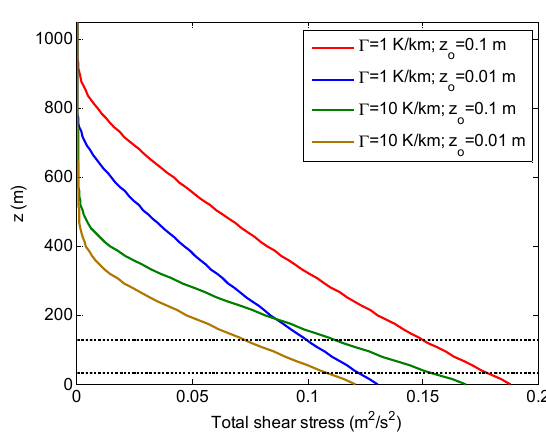
Figure 3. Vertical profile of total shear stress (cid:3436)(cid:3495) τ (cid:2934)(cid:2936)(cid:2870) + τ (cid:2935)(cid:2936)(cid:2870) (cid:3440) for two different values of Γ and z (cid:2925)